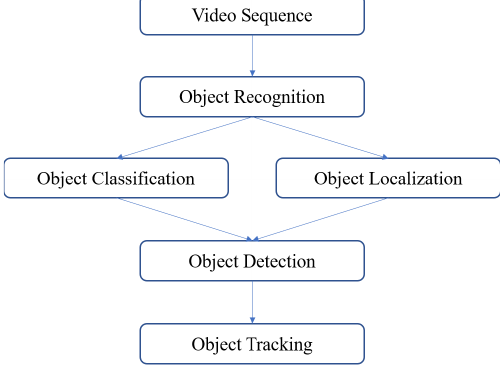
Figure 1. Flowchart of an MOT